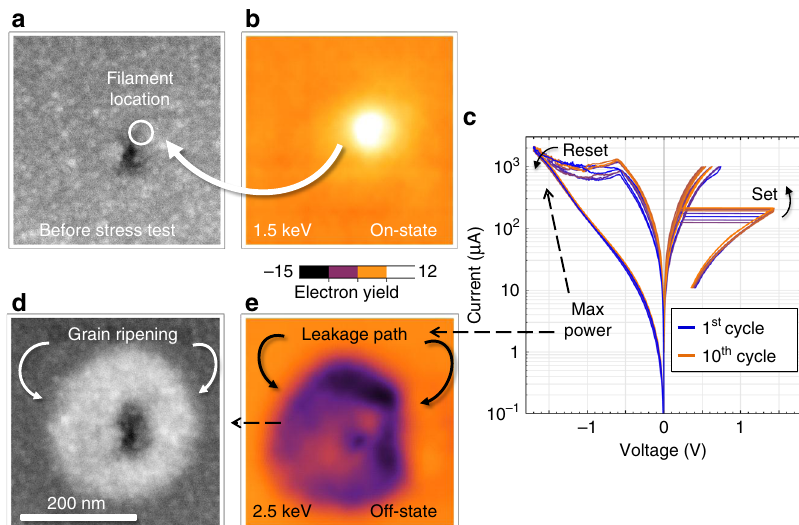
Fig. 9 Stress testing of device. a Scanning electron micrograph of an asymmetric standard device after forming and switching. Area adjacent to the fi lament is damaged by the switching. b Electron beam induced current (EBIC) image of the device in the on state with a low 1.5 keV beam energy. c Depiction of a 10 switching curve stress test taken after image a. d Scanning electron micrograph and e corresponding EBIC image showing correspondence between grain coarsening (seen in d ) and background crystallization region (region of negative current in